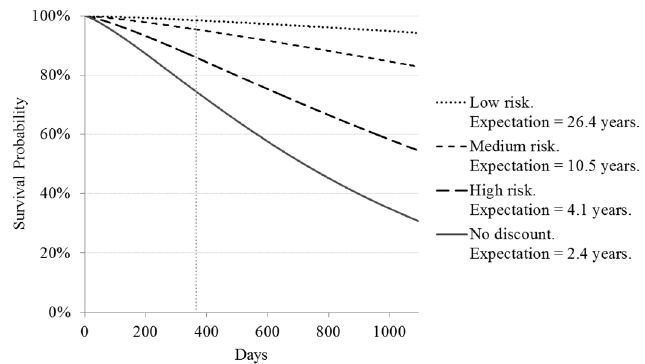
Figure 3. Survival curve for the time to the first accident at fault for women.